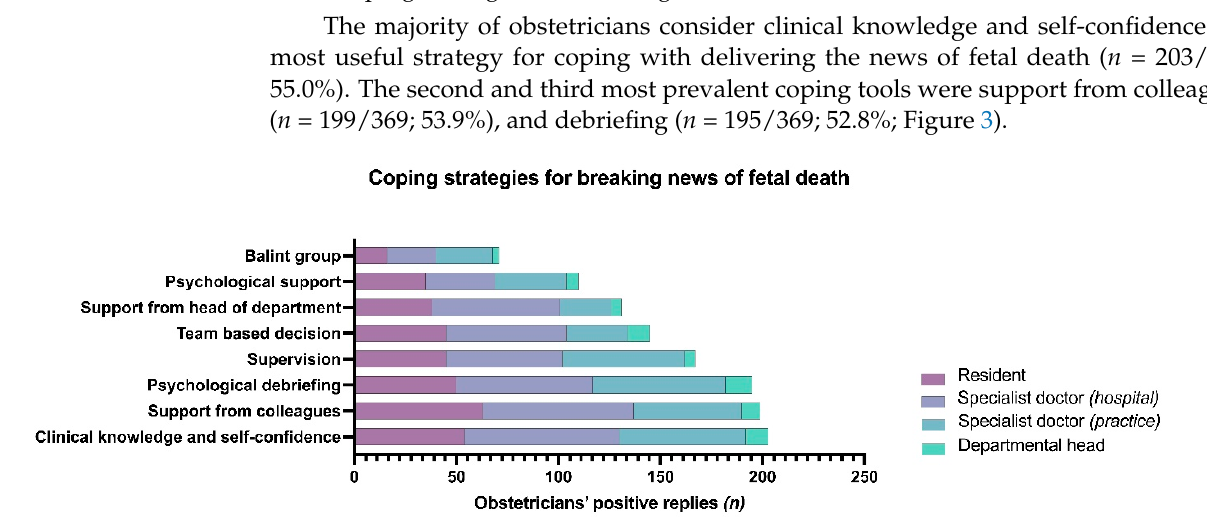
Figure 3. Clustered bar chart on the frequency of coping strategies among obstetricians for breaking news of fetal death.